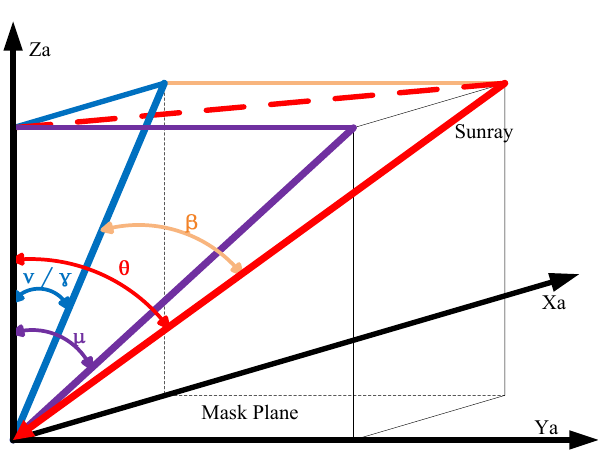
Figure 4. Illustration of angle definitions.